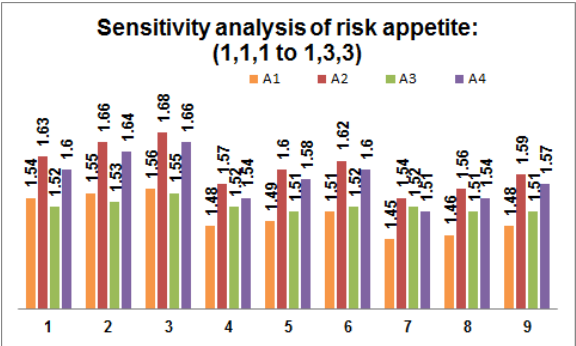
Figure 2. Sensitivity analysis of risk appetite of each DM ((1) 1,1,1 to (9) 1,3,3).